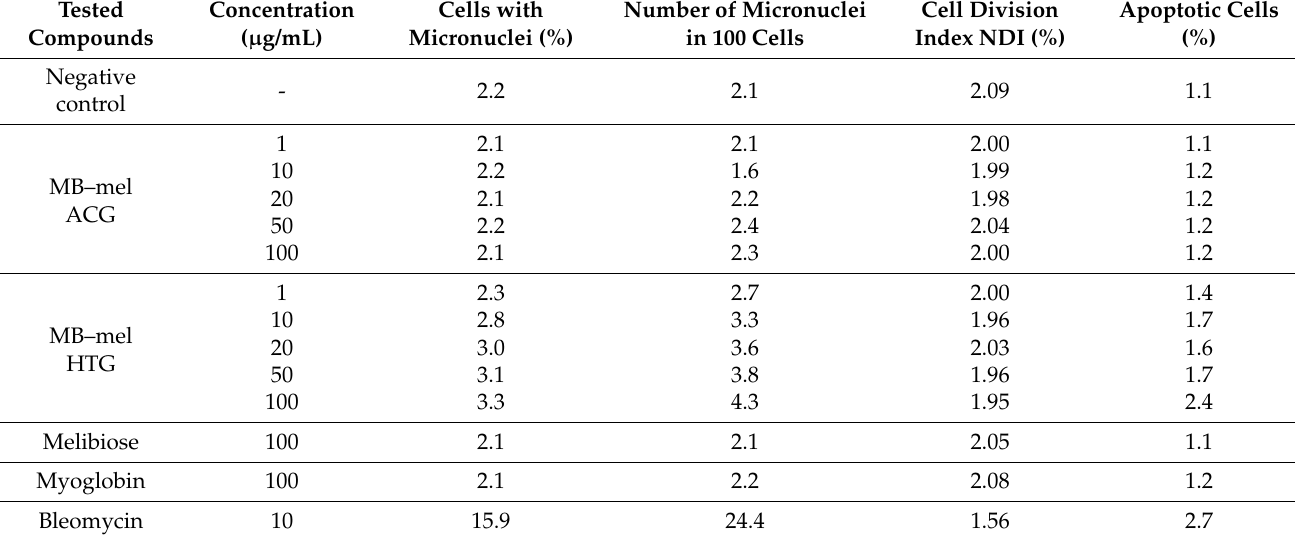
Table 5. The effect of advanced glycation end-products on A549 cells.